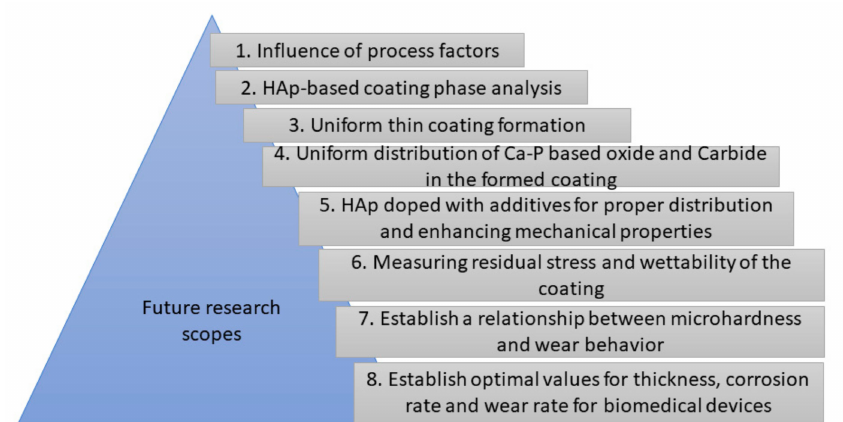
Figure 10. Summary of future research